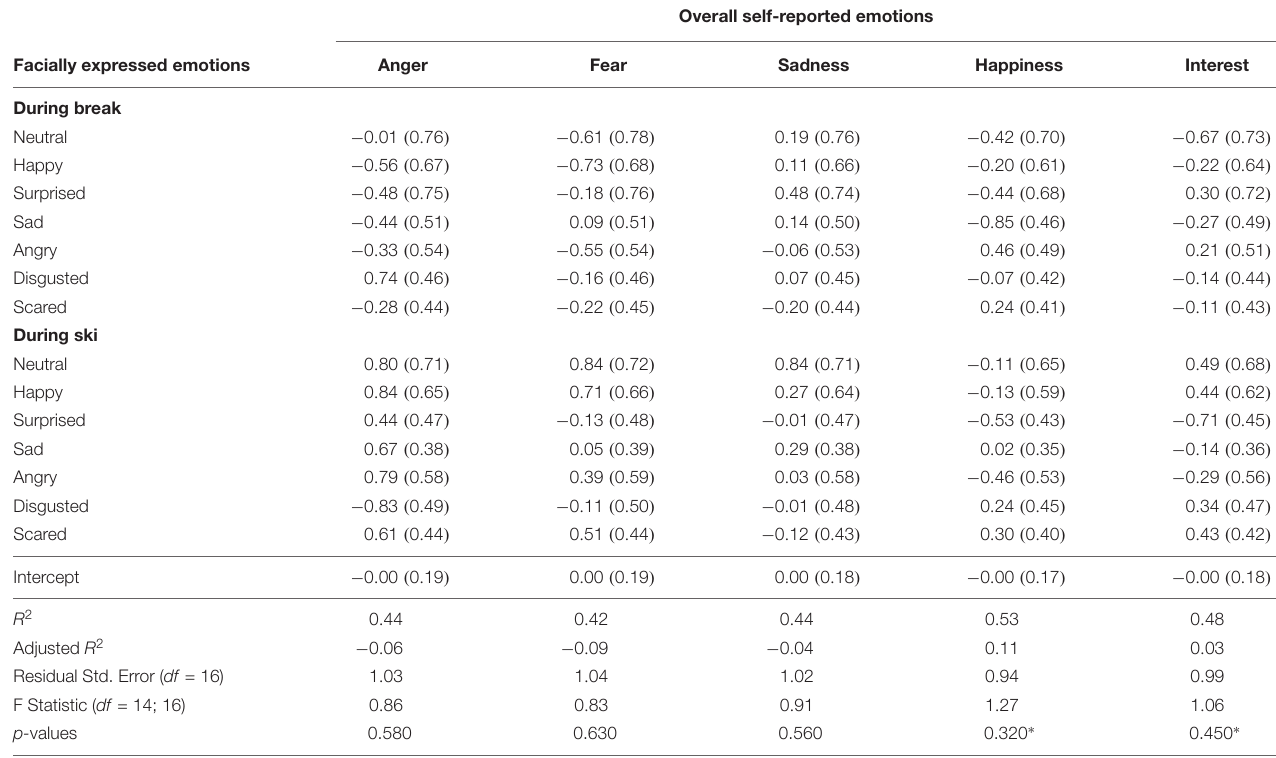
TABLE 4 | Standardized regression coefficients ( β ), standard errors (in parenthesis) and overall statistics for five models predicting self-reported event emotions by the means of the facially expressed emotions during breaks (upper part) and skiing (lower part). Overall self-reported